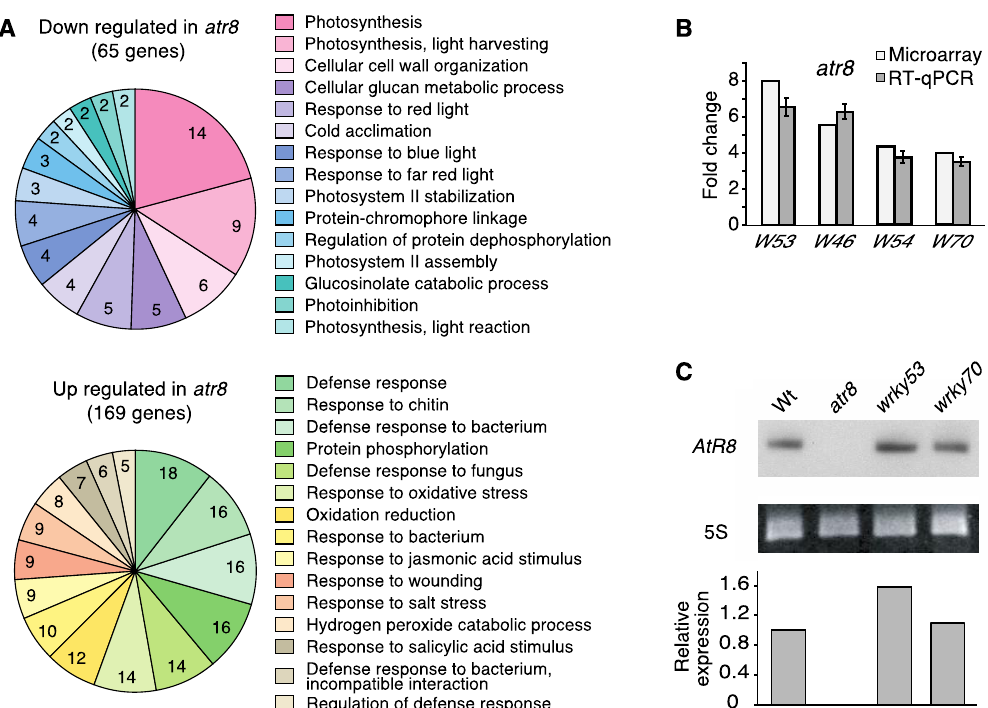
Figure 1. Microarray analysis and WRKY genes accumulation in atr8 mutant. ( A ) Microarray analysis using the total RNAs from atr8 and wild-type (Wt) in combination with Affimetrix GeneChip (ATH1 Arabidopsis expression array). Function categories of down- and up-regulated genes were obtained by a hypergeometric distribution test (cf. Supplemental Table S2). Each of the top 15 categories are shown on a pie chart with the number of genes classified. ( B ) Comparison of WRKY transcription factor (TF) gene accumulation in atr8 mutant dipped in water for 6 h and then recovered for 24 h. These mRNA accumulation levels were determined by GeneChip and RT-qPCR with the same RNA samples, while ACT2 and ACT8 genes were used as standards for RT-qPCR. Bar graphs represent the mean values of three independent assays, and the error bars represent ± SE. W53 : WRKY53 , W46 : WRKY46 , W54 : WRKY54 , and W70 : WRKY70. ( C ) RNA gel blot analysis showing the basal expression of AtR8 lncRNA in Wt as well as the atr8 , wrky53 , and wrky70 mutant treated with water as ( A ). The quantification of the gel blot was made using ImageJ.